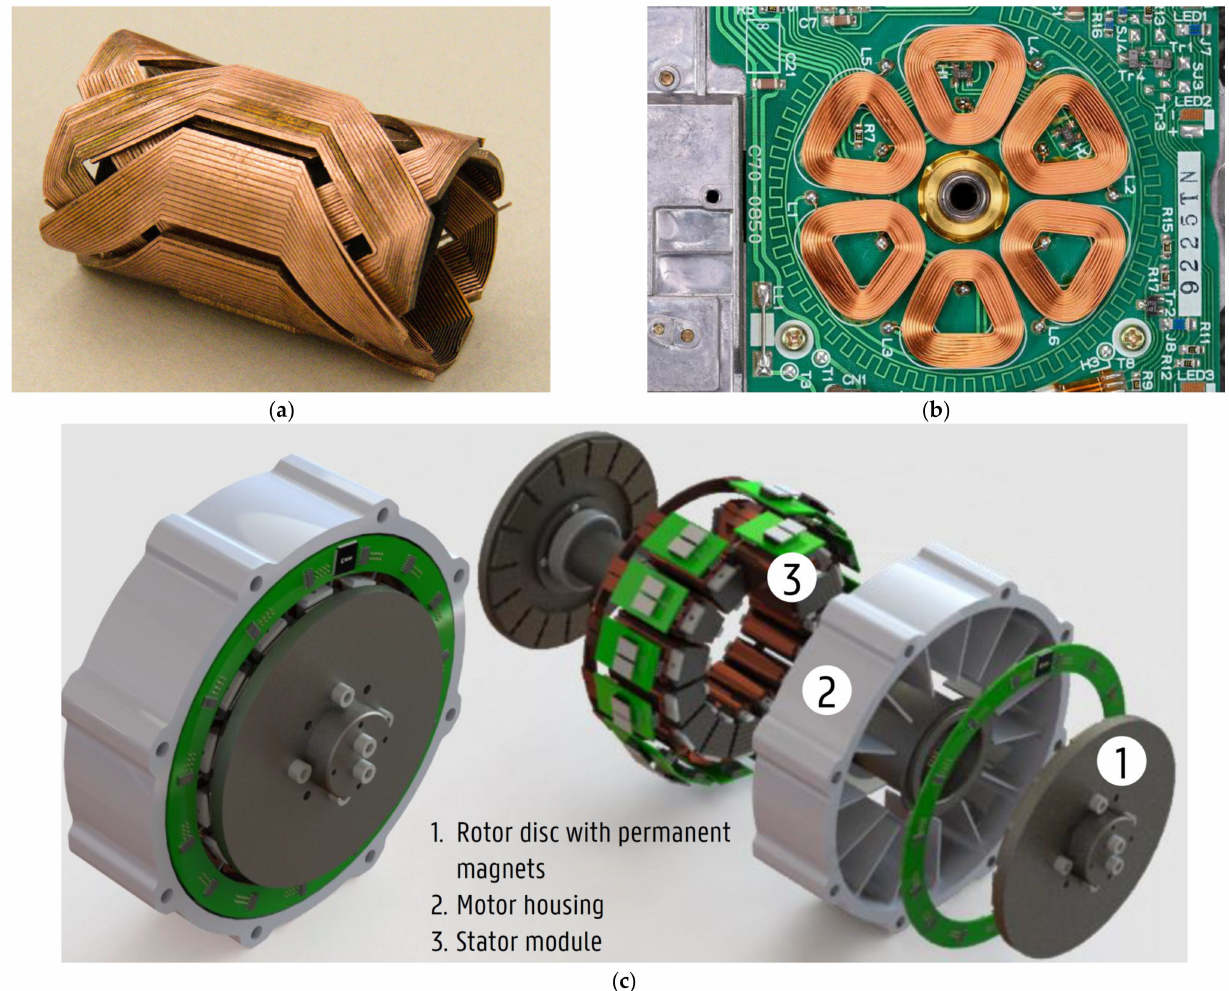
Figure 20. Brushless DC machines. ( a ) Six-coil slotless winding [74]; ( b ) PCB windings [75]; ( c ) modular axial flux electrical machine